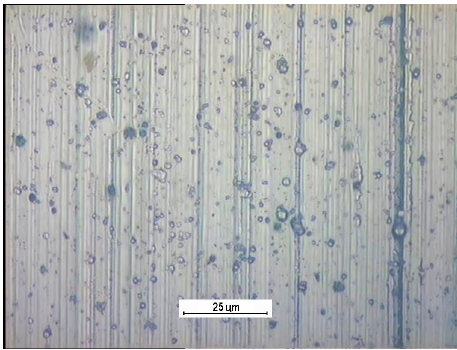
Figure 20. Optical microscope image of the surface of the W ‐ DLC/CrN coating.